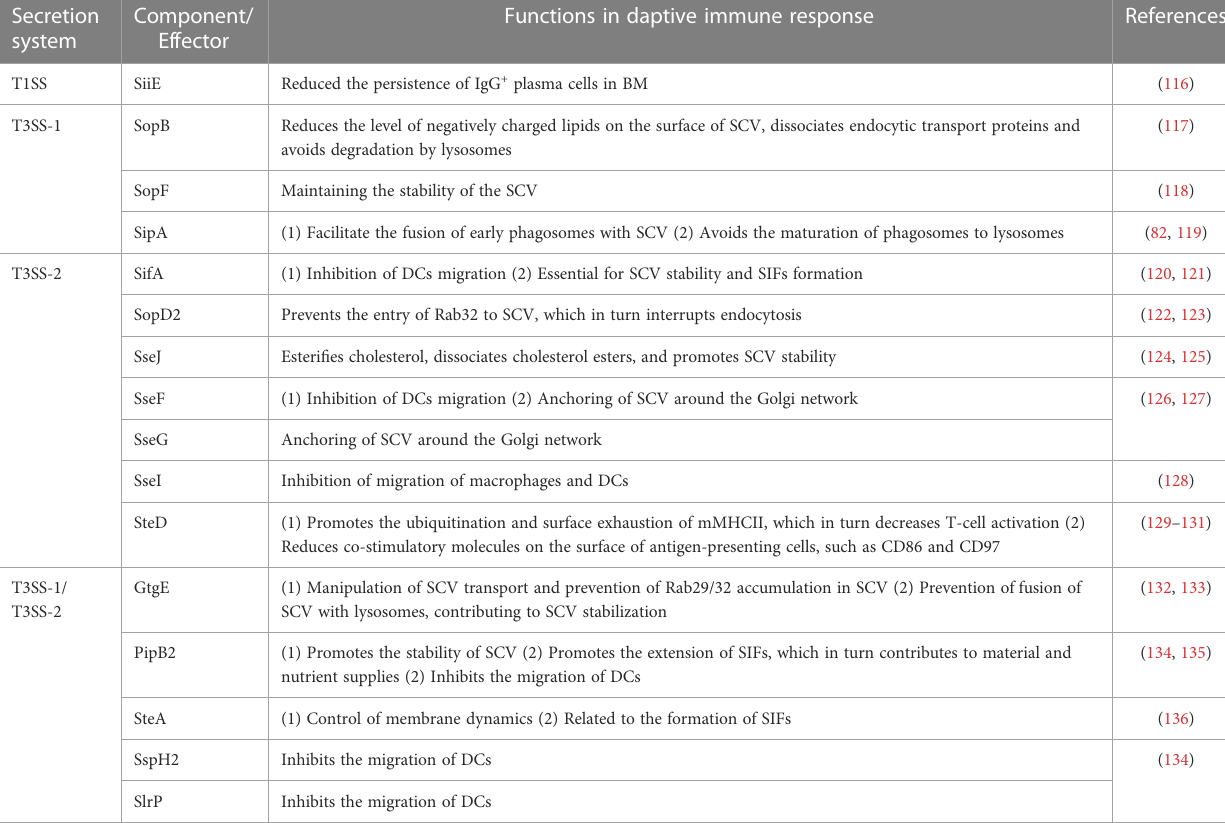
TABLE 1 Effector proteins involved in adaptive immune